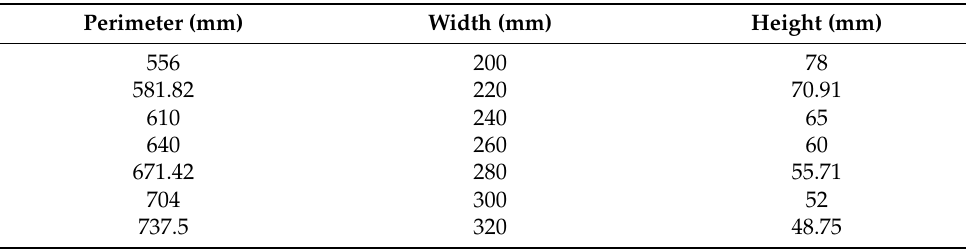
Table 6. Single loop rectangle dimensions with a constant area (15,600 mm 2 ).